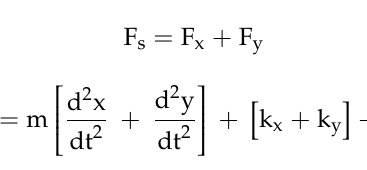
Figure 6. Nonlinear torque profile of torque winding.